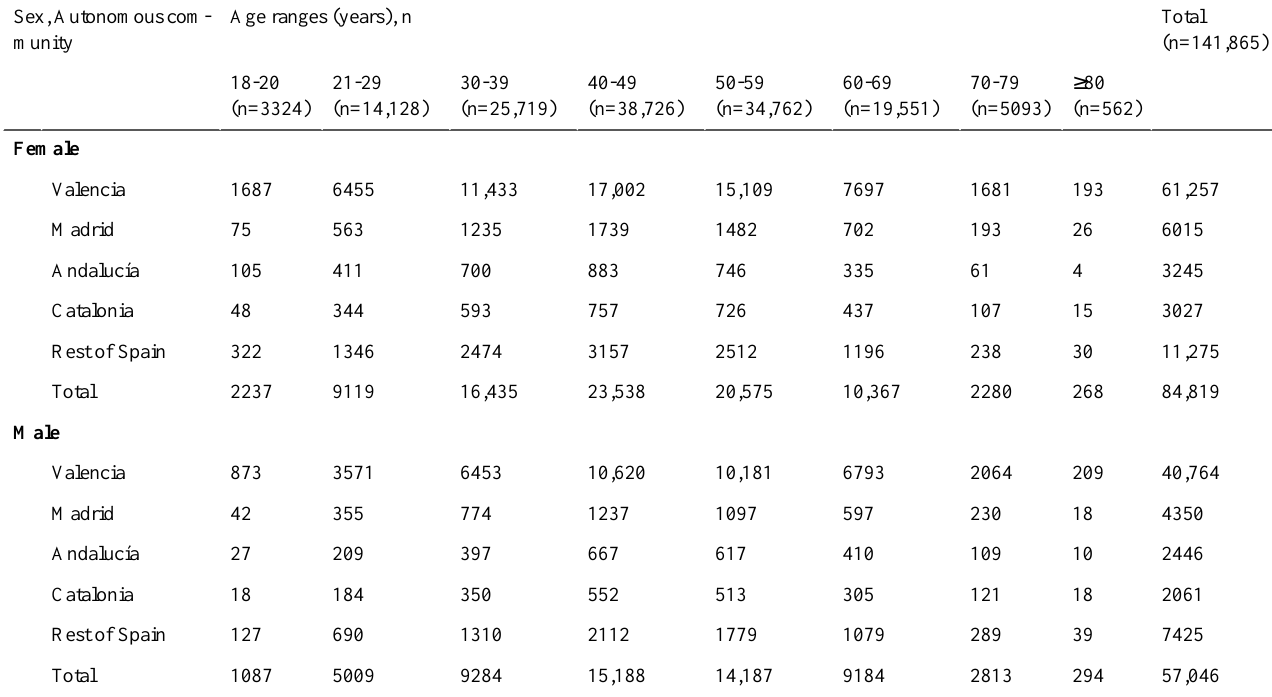
Table 1. Age, gender, and geographical distribution of survey respondents (raw, unweighted